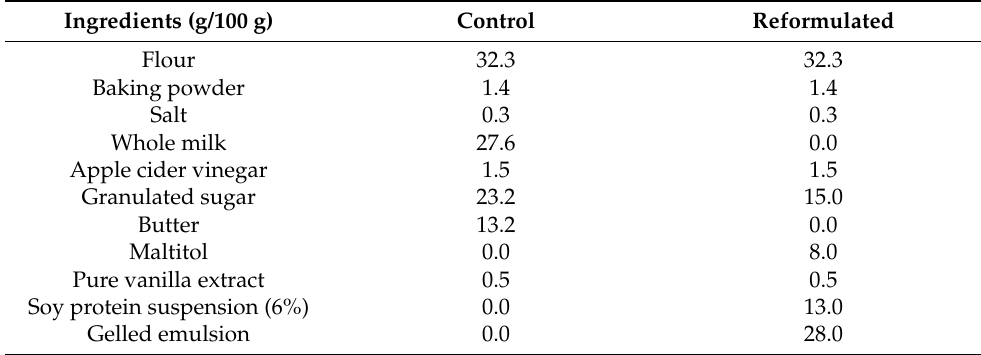
Table 1. Formulations of control and reformulated